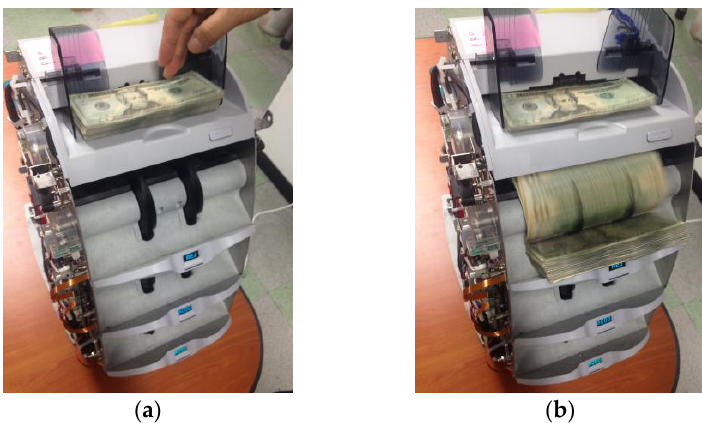
Figure 2. Examples of data acquisition of our research: ( a ) Input banknotes; ( b ) Acquisition of image data.